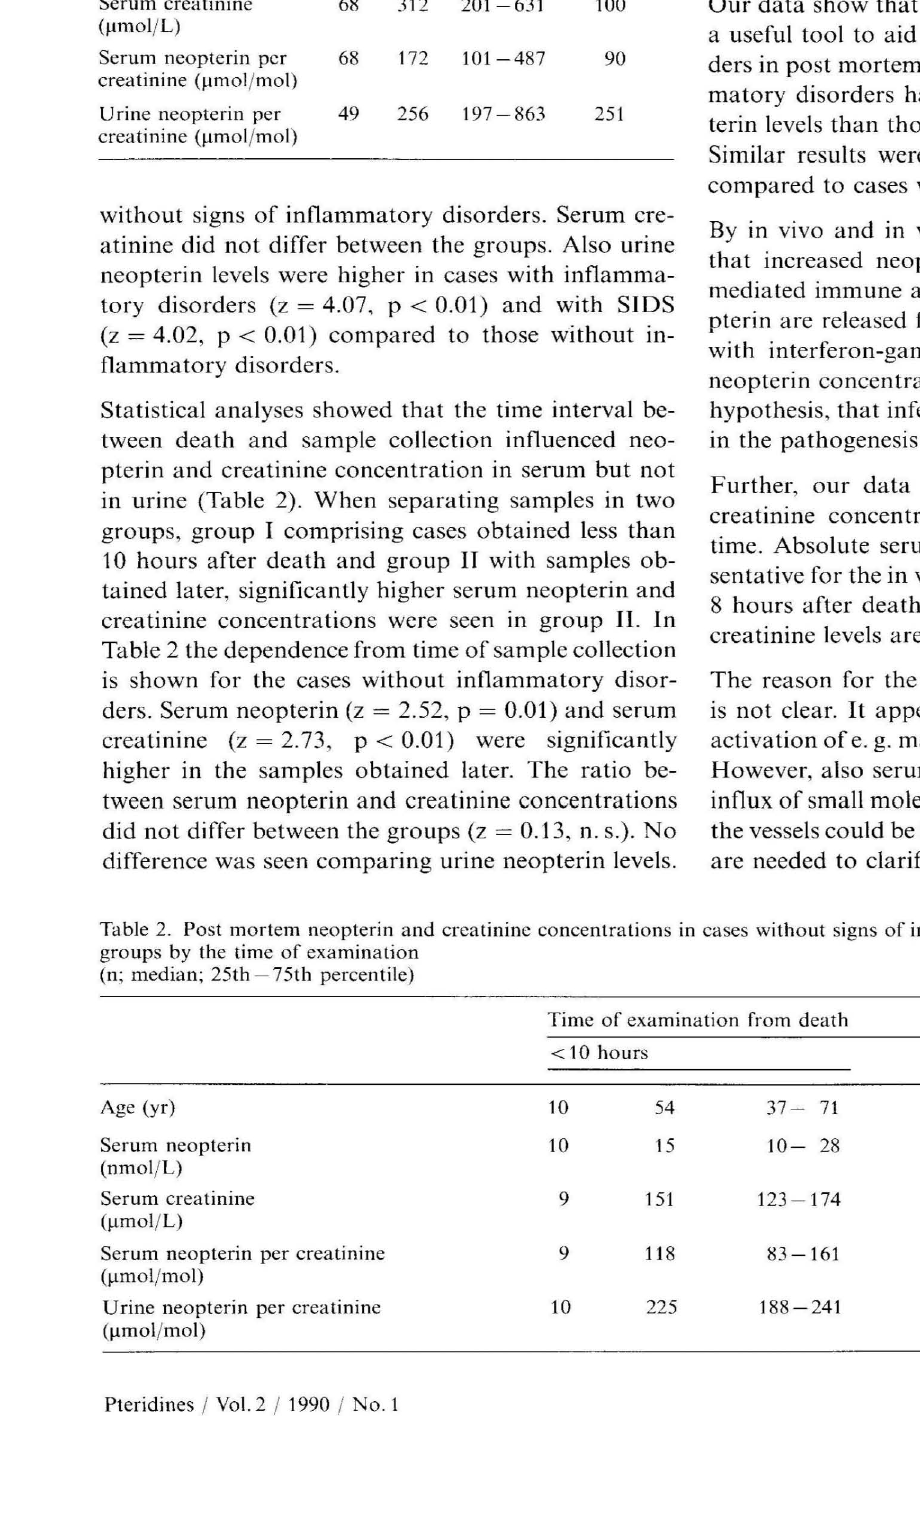
Age (yr) Serum neopterin (nmol/L) Serum creatinine (J.lmol/L) Serum neopterin per creatinine (J.lmol/mol) Urine neopterin per creatinine (J.lmoljmol)